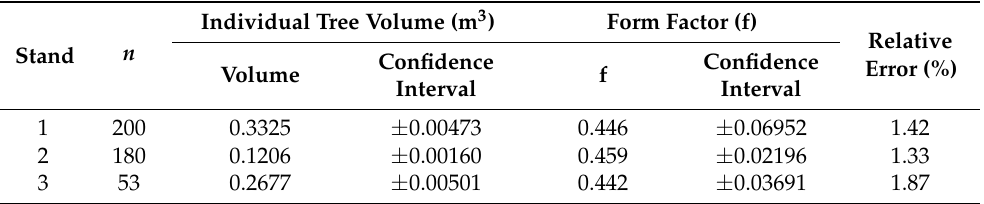
Table 2. Confidence intervals and precision for stem volume and form factor by ratio estimator.